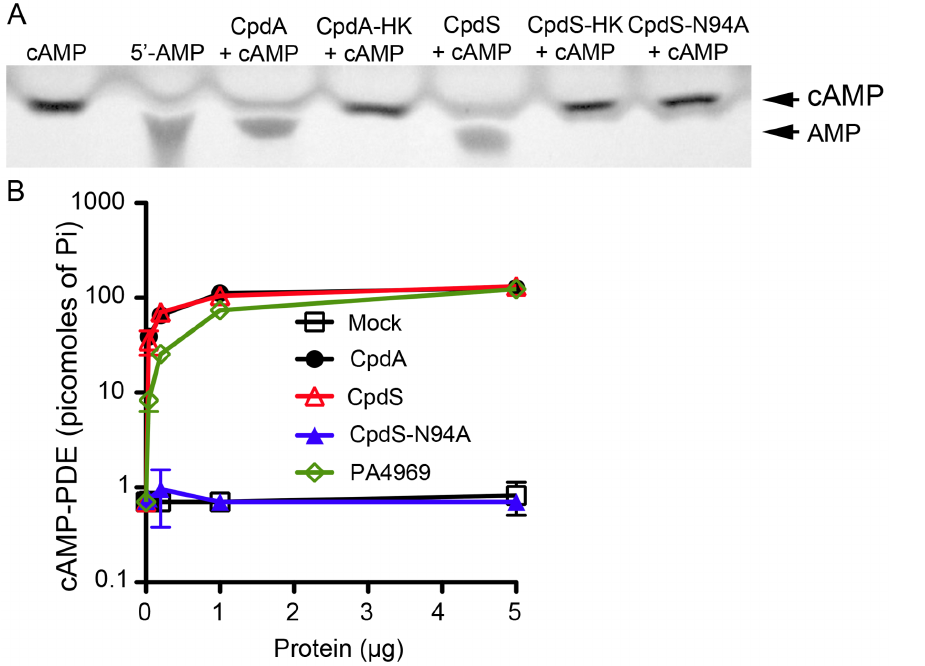
Figure 2. CpdS exhibits cAMP-PDE activity invitro . A. Thin layer chromatography to examine cAMP-PDE activity from purified CpdA from E. coli , CpdS, and CpdS-N94A mixed with cAMP. HK = indicates heat killed protein before being mixed with cAMP. B. cAMP-PDE assay shows dose responsive activity by CpdS and positive controls CpdA and PA4969 (CpdA from P. aeruginosa ), but not by the CpdS-N94A mutant or a mock purified protein.